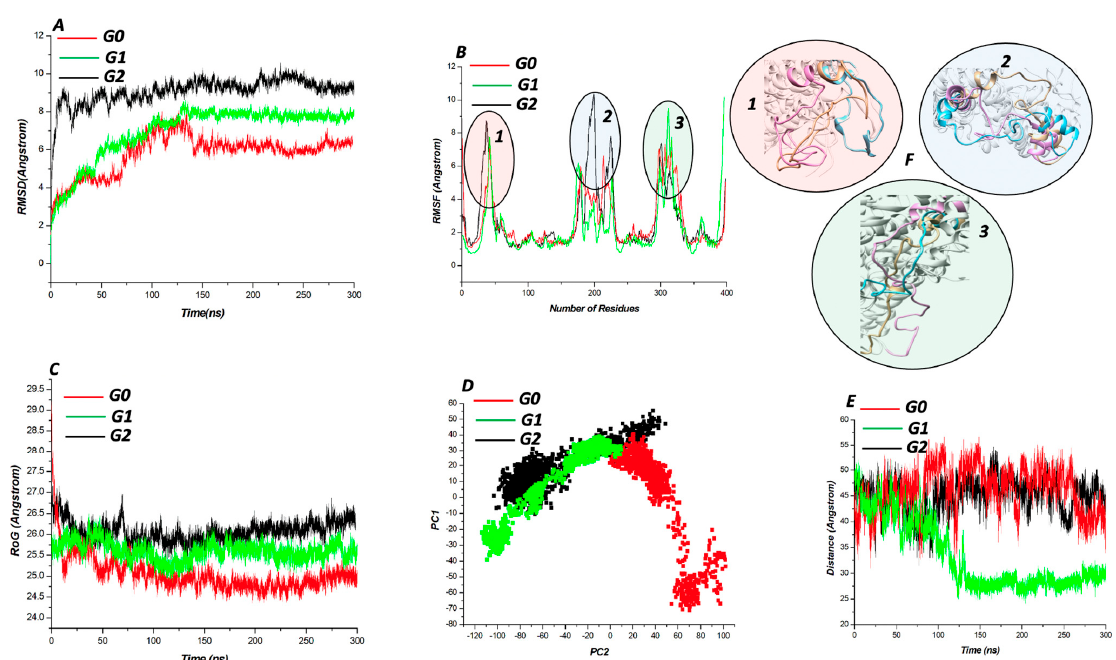
Figure 2. Backbone RMSDs depicted as a function of time for G0 (red), G1 (green), and G2 (black) ( A ). C α fluctuation of G0 (red), G1 (green), and G2 (black) ( B ). RoG plot of G0 (red), G1 (green), and G2 (black) ( C ). PCA scatter plots depicting a distinct separation of motions between G0 (red), G1 (green), and G2 (black) ( D ). Intermolecular distance plot of G0 (red), G1 (green), and G2 (black) ( E ). The 3D structures of highly fluctuating region in the system ( F ).